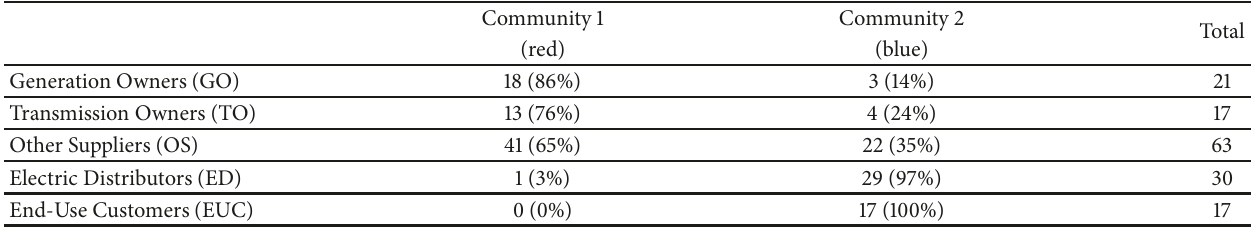
Table 5: The number of voters in the detected communities by industry sectors (yes